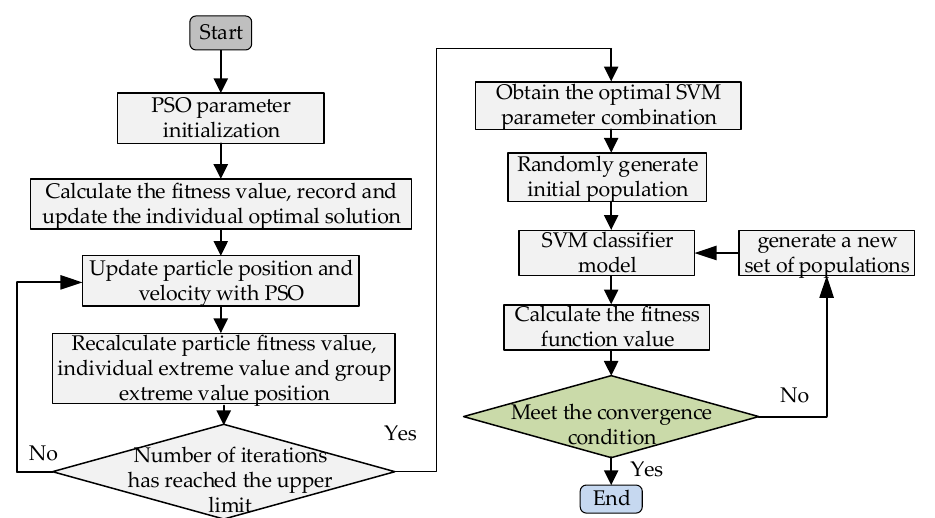
Figure 9. Flowchart of PSO to optimize meta-classifier (SVM) hyperparameters. First of all, the initialization stage of the PSO parameter sets the step size and